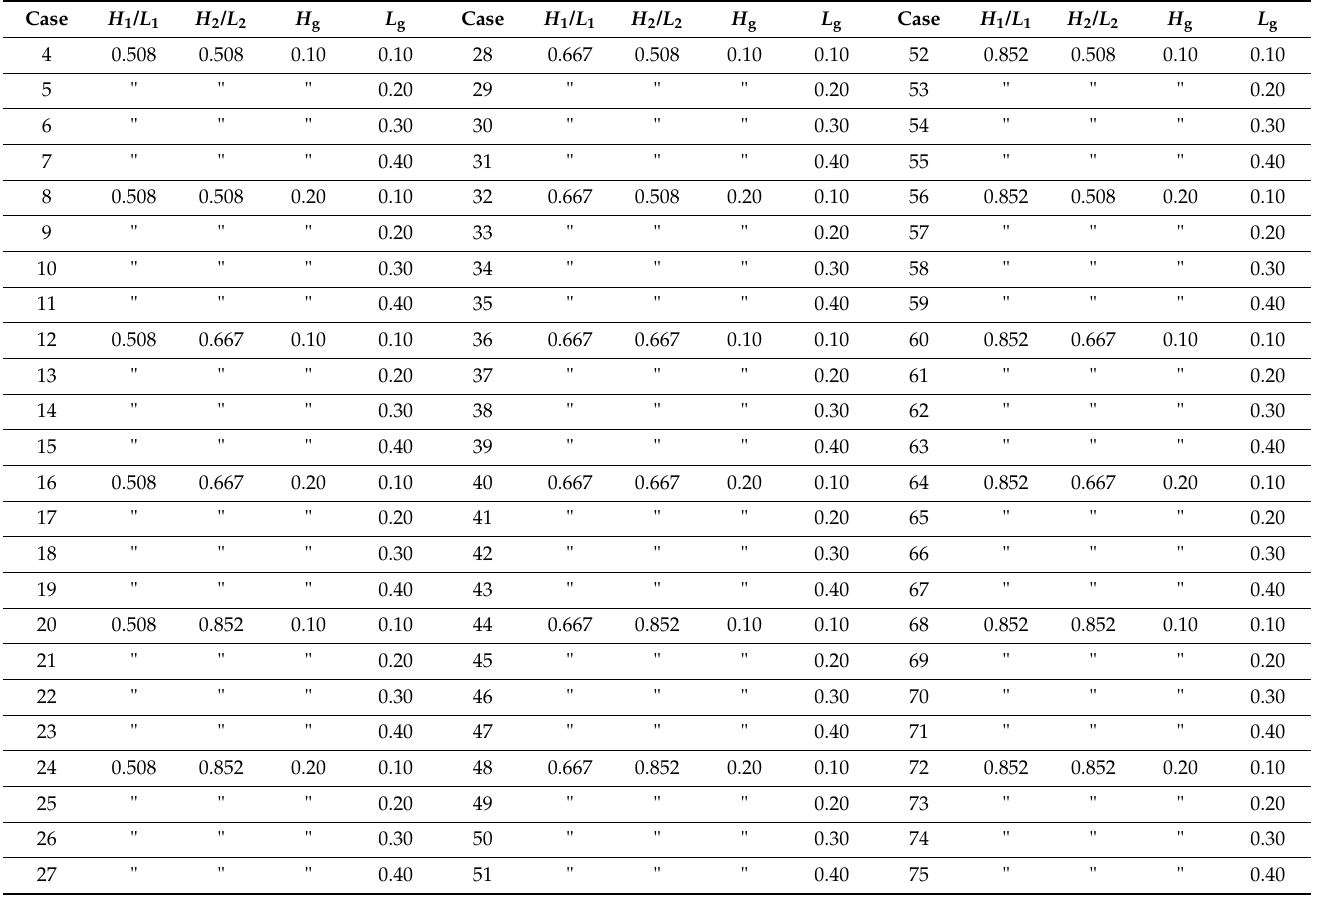
Table 3. Geometric evaluation of OTD-WEC with two ramps and four degrees of